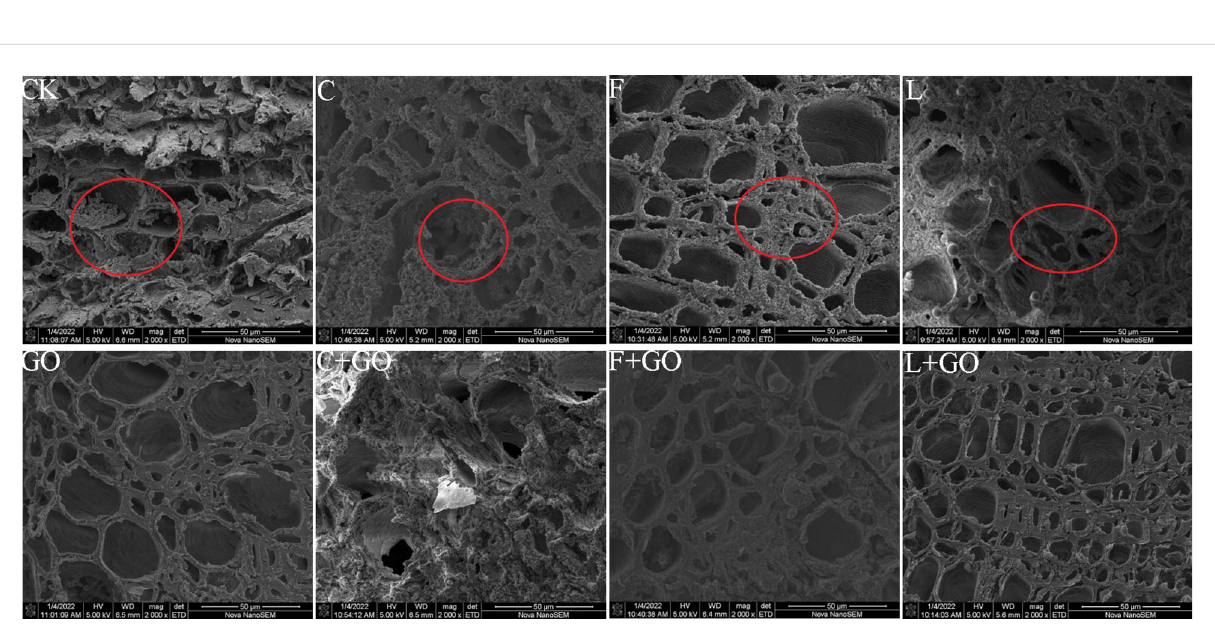
FIGURE 9 Micrographs of the stem incisions of the cut rose fl owers after 6 d of treatment observed using scanning electron microscopy. Scale bar: 50 m m.